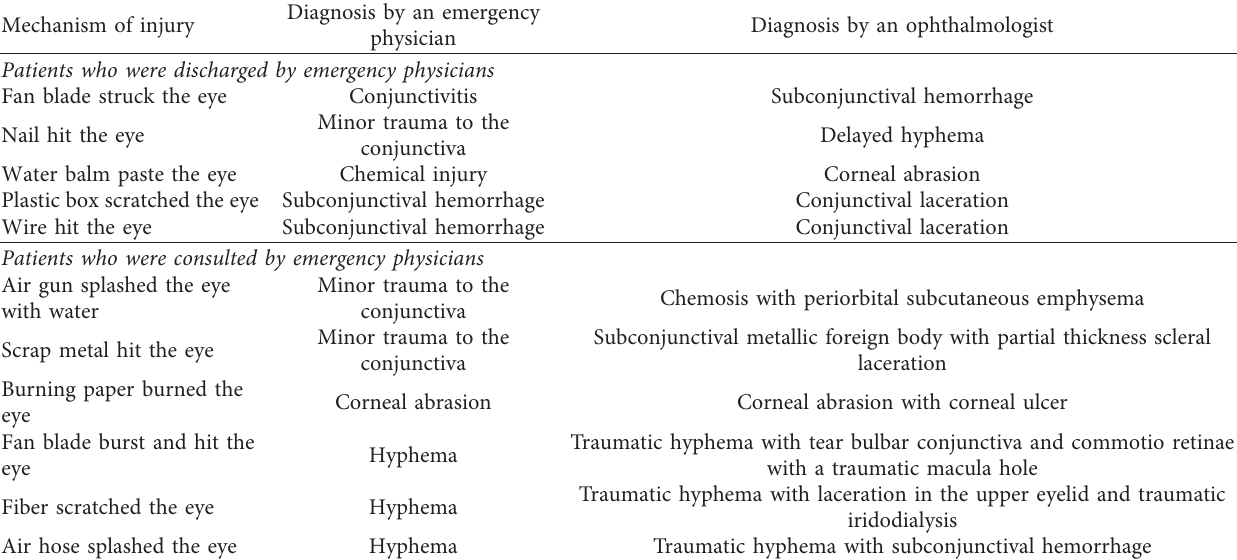
Table 7: Comparison of final diagnosis of patients who were discharged by emergency physicians and consulted